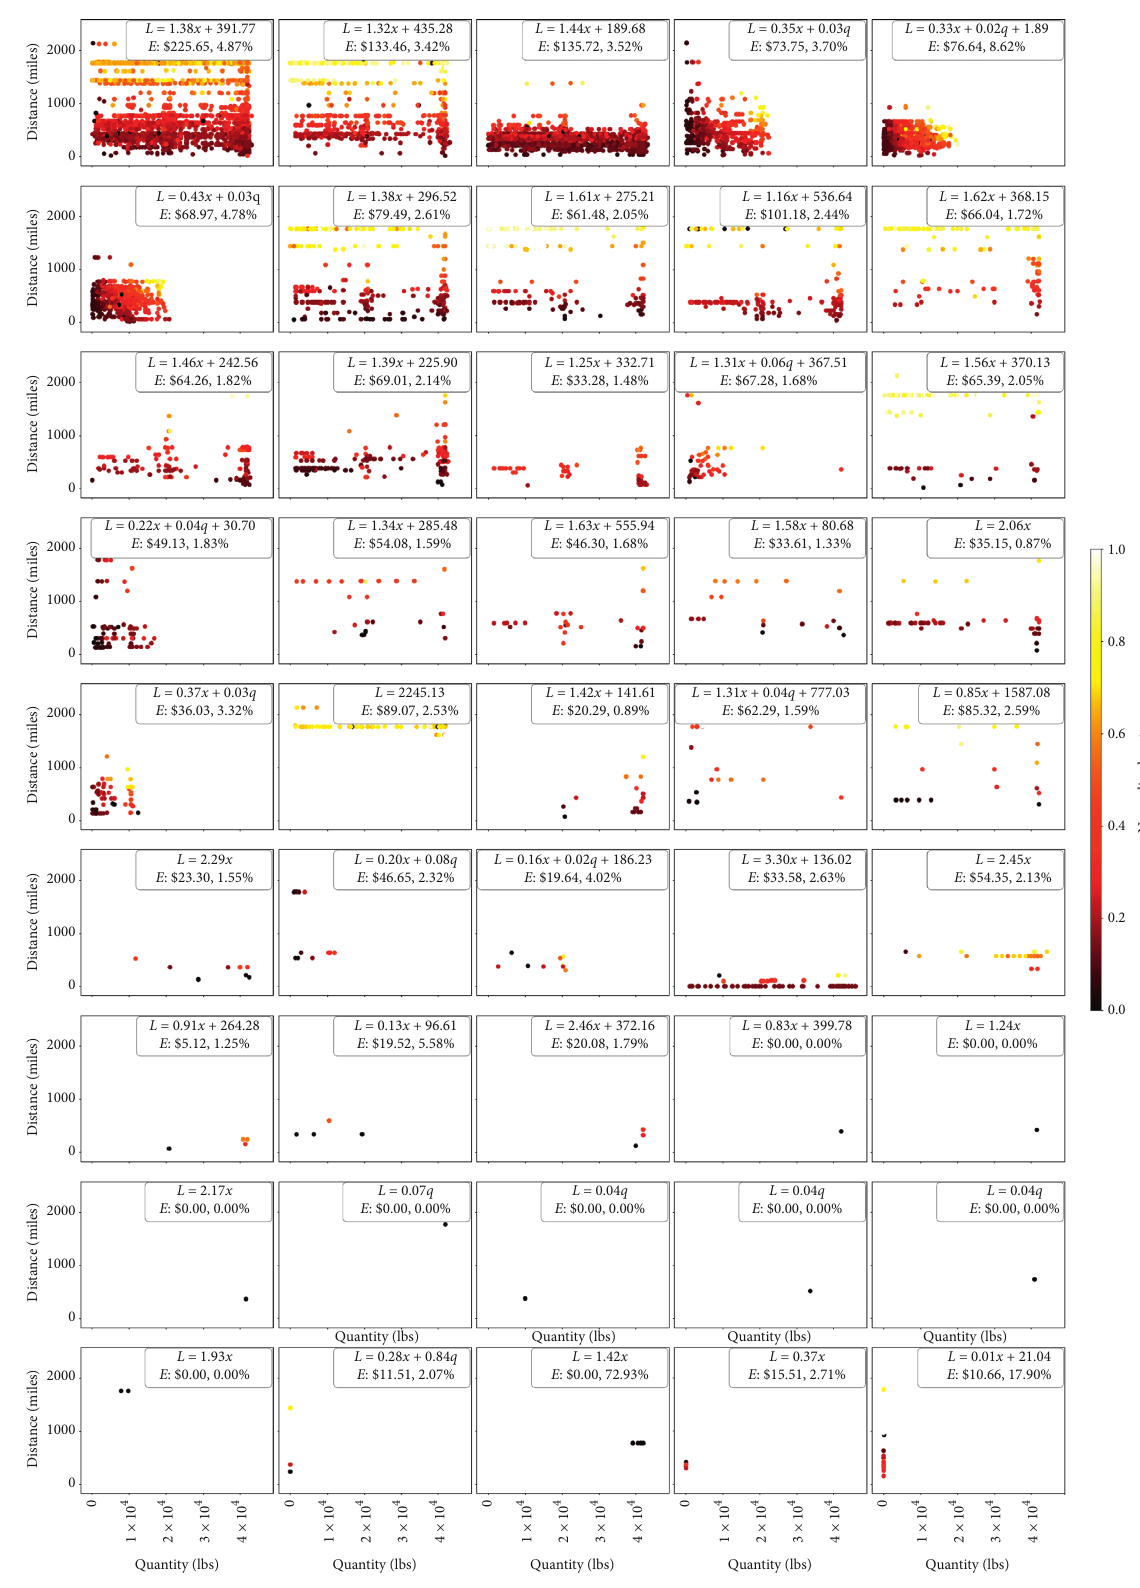
Figure 7: Distance versus quantity scatter plots for box truck carriers. Color indicates freight cost (key on right), normalized to [0, 1] for each carrier to have a minimum cost of 0 and a maximum cost of 1. Cost equations are obtained by performing regression analysis on each carrier. Weights are constrained to have positive values. In each cost equation (inset), L indicates the cost equation of the carrier, x denotes the distance in miles, q denotes the quantity in pounds, and E denotes the absolute error of the cost regression in dollars and as a percentage. Carrier names are omitted to preserve